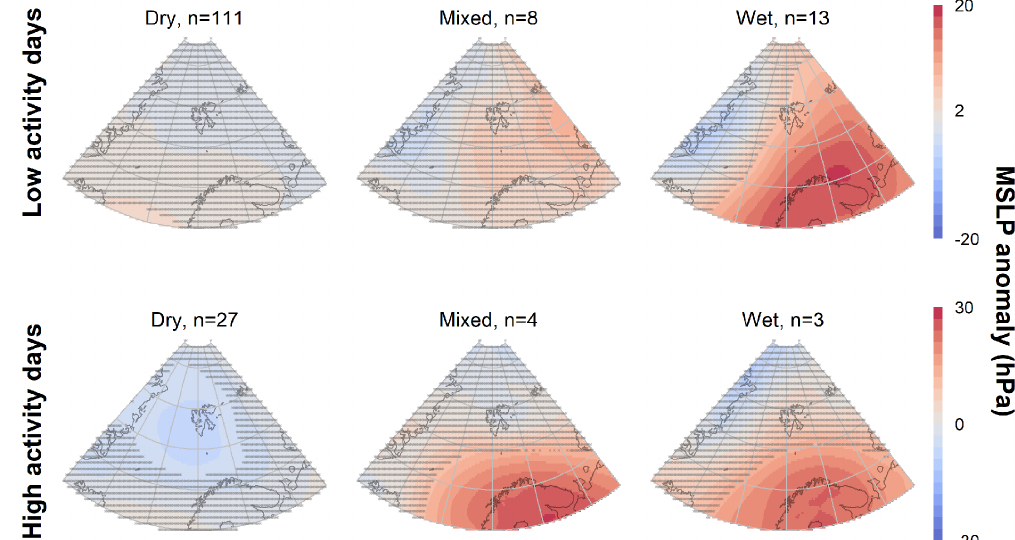
Figure 7. Maps of composite MSLP anomalies versus mean winter MSLP conditions (December–May, 2016–2020) by dry, mixed, and wet avalanche activity classifications. Anomalies which are not statistically significantly different from mean winter conditions are indicated with dense hatching. Additional parameter plots are found in Appendix C. Table 1. Distribution of total winter days and avalanche activity by synoptic type after Nied´zwied´z (2013). Maximum values for each column are displayed in bold. Appendix A shows the composite parameter field anomalies for each synoptic type over our period of